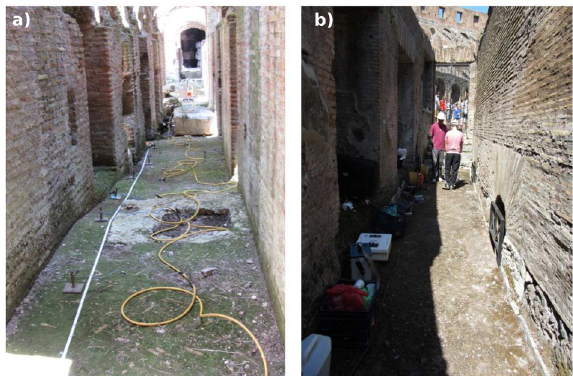
Figure 5. Pictures from data acquisition within the hypogeum . (a) ERT survey employing non-invasive copper electrodes. (b) GPR